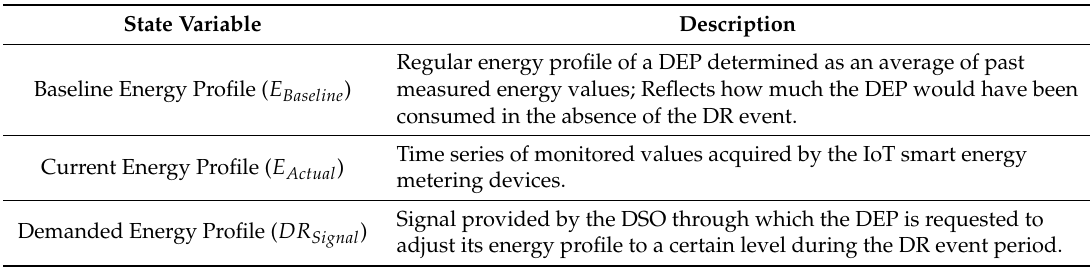
Table 2. DEP’s smart contract state variables and